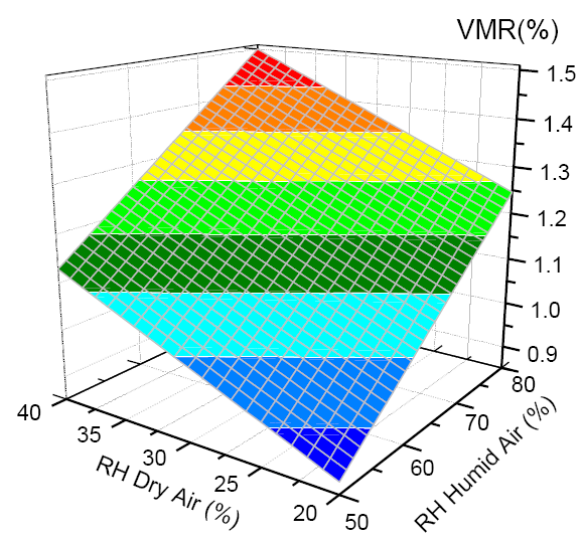
O molecules in the cavity 2